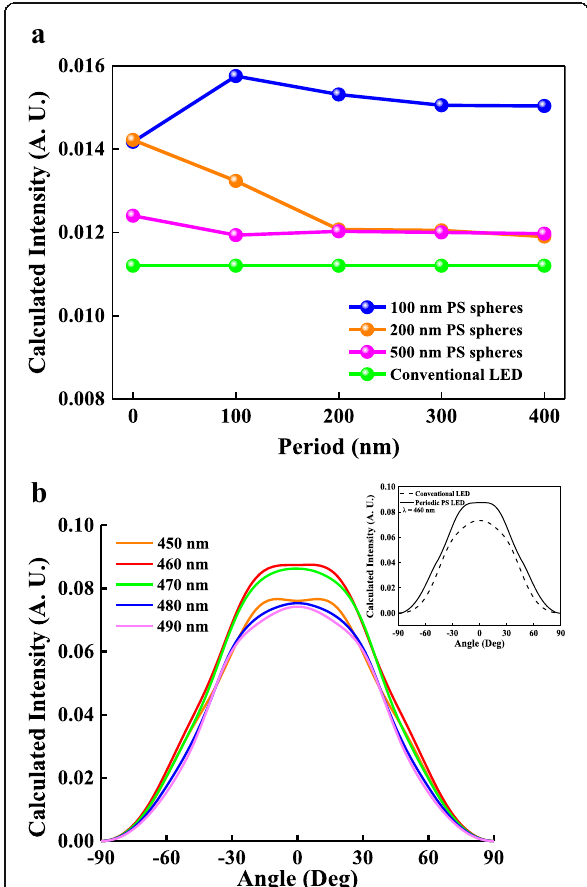
Fig. 4 Calculated intensity of a conventional LEDs and LEDs with different periods for PS NSs with 100 and 200 nm diameters and ( b ) varied angle under the different emission wavelength. The inset of b display the angular spectra of InGaN/GaN blue LED with the optimal periodic PS NS array window layer and without PS NS array window layer under emission wavelength of 460